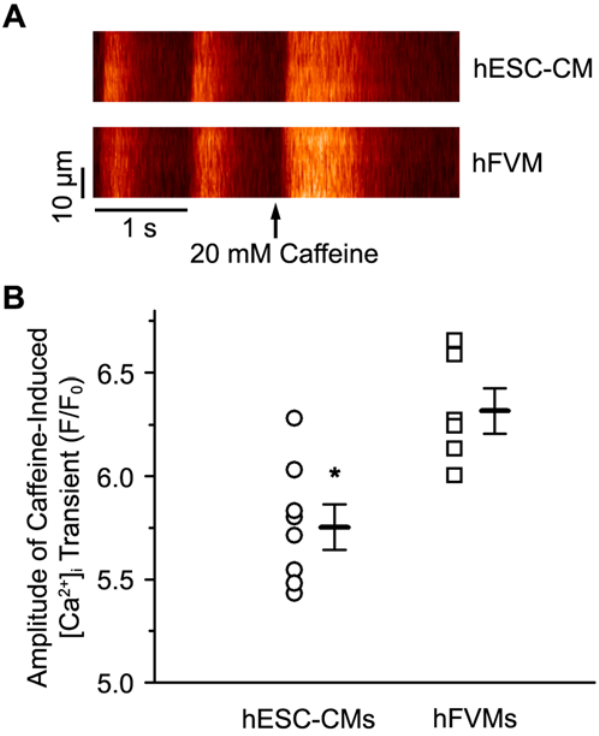
Figure 7. Higher SR Ca 2 + load in hFVMs than in hESC-CMs. A. Line-scan images showing AP-evoked and caffeine-induced [Ca 2 + ] i transients in hESC-CMs (upper image) and hFVMs (lower image). Delivery of the 20 mM caffeine is indicated by the arrows. B. Scatter plot of the amplitude of the caffeine-induced [Ca 2 + ] i transient in hFVMs and hESC-CMs. The horizontal bars in the plot show the mean 6 SEM of the caffeine-induced [Ca 2 + ] i transient in each experimental group. * p , 0.05.